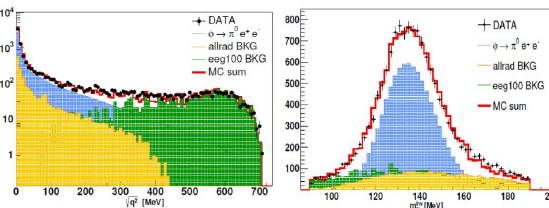
Figure 6: Left : e + e − invariant mass distribution for φ → π 0 e + e − . Right : two photon invariant mass for φ → π 0 e + e −